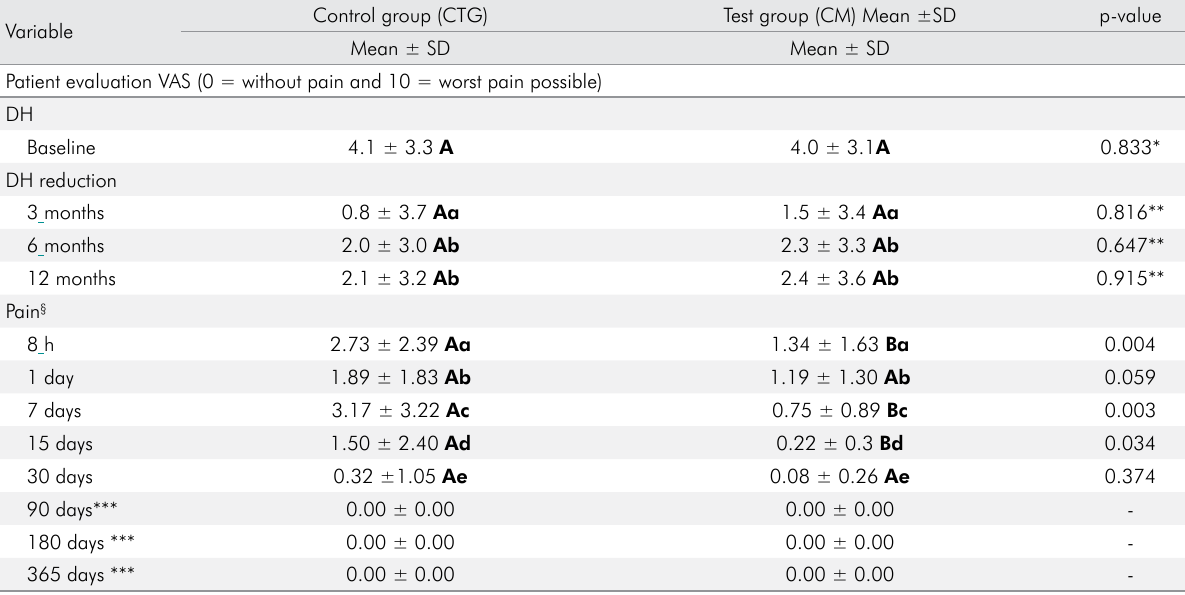
Table 3. Descriptive analysis of patient evaluation: DH and pain a comparison between groups.